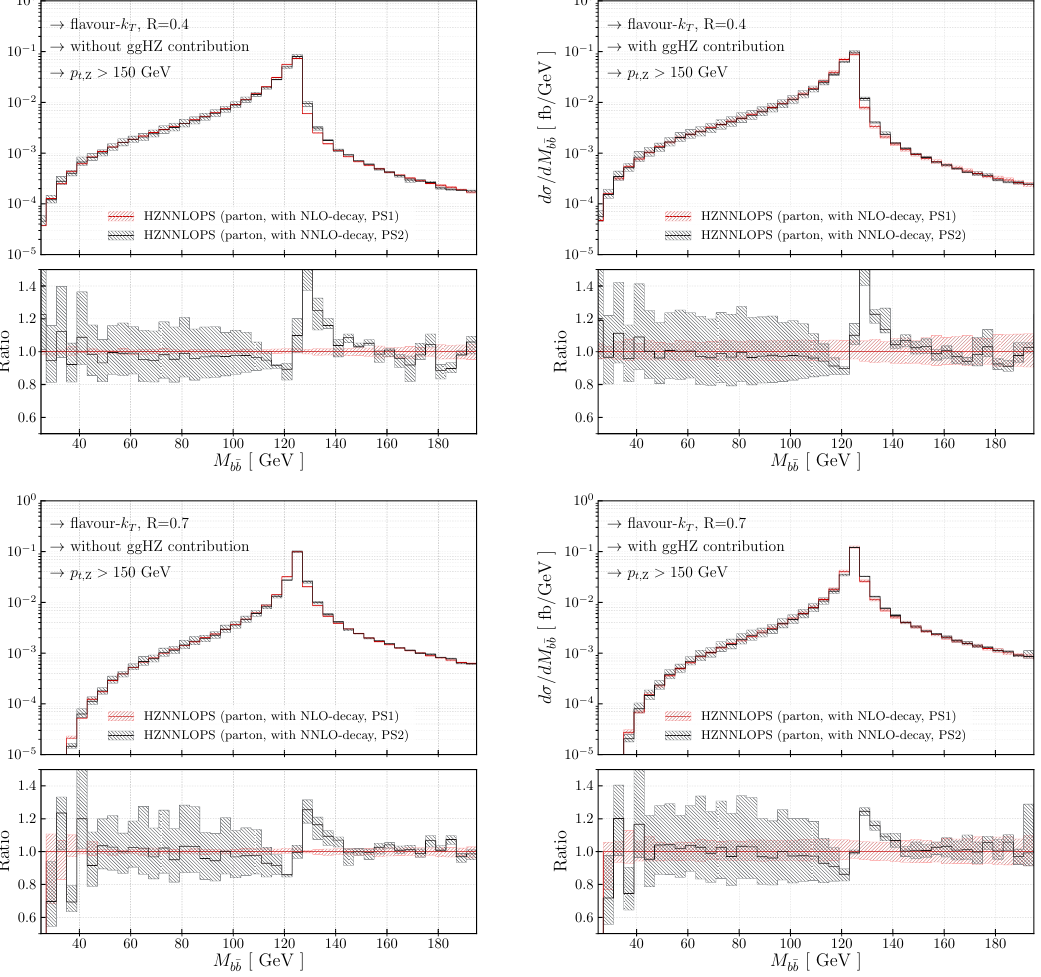
Figure 2 . Invariant mass of the two b -jets reconstructed using with the (cid:13)avour- k R = 0 : 4 (upper plots) and R = 0 : 7 (lower plots). Left (right) plots are without (with) gluon-induced terms. We show the NNLOPS predictions of ref. [30], which have only NLO corrections to the decay (red) and the predictions of this work (black). Predictions of ref. [30] and this work also di(cid:11)er in the handling of the matching to the parton shower, see text for more